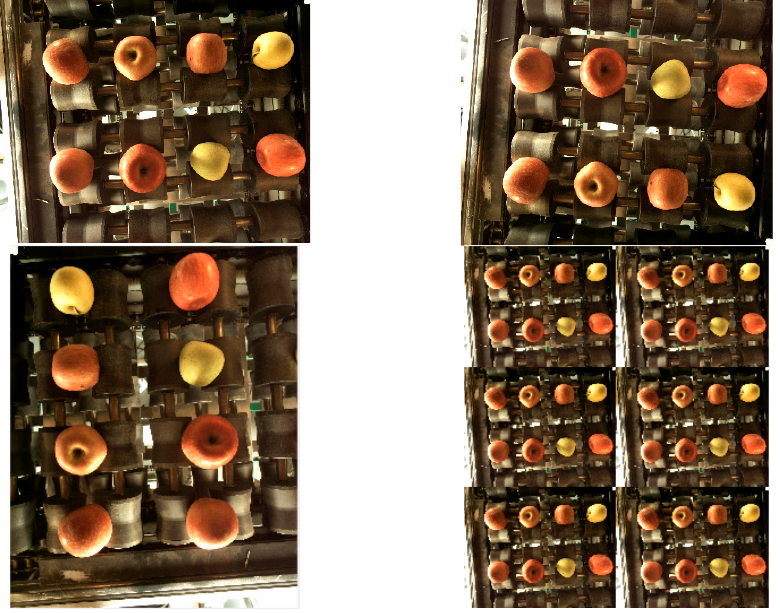
Figure 7. The expanded dataset.